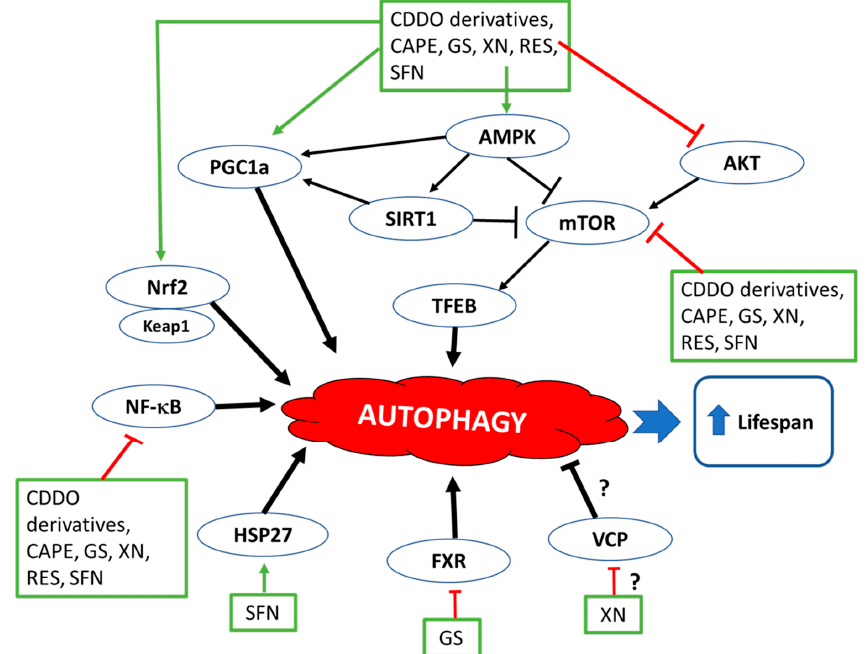
Figure 2. Regulation of autophagy by phytochemicals. Activation of AMPK signaling pathway promotes autophagy through the activation of multiple signaling molecules and transcription factors, including but not limited to SIRT1 and PGC1-a and the inhibition of mTOR [188]. mTOR further phosphorylates and inactivates TFEB, an important regulator of autophagy. Inhibitors of mTOR and its upstream pathway, Akt signaling, can promote autophagy [189]. Similarly, inhibitors of NF- κ B have the potential to enhance the completion of autophagy process [190]. Nrf2, when bound to Keap1, a major regulator of Nrf2, is quickly degraded but under oxidative stress, it gets released from Keap1 to regulate autophagic process by getting translocated into the nucleus to activate the transcription of target genes [191]. Phytochemicals reviewed in this manuscript activate or inhibit multiple pathways to modulate autophagy.